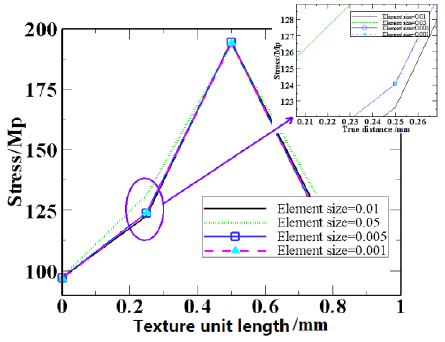
Figure 3. Comparison of computational results of different element sizes.